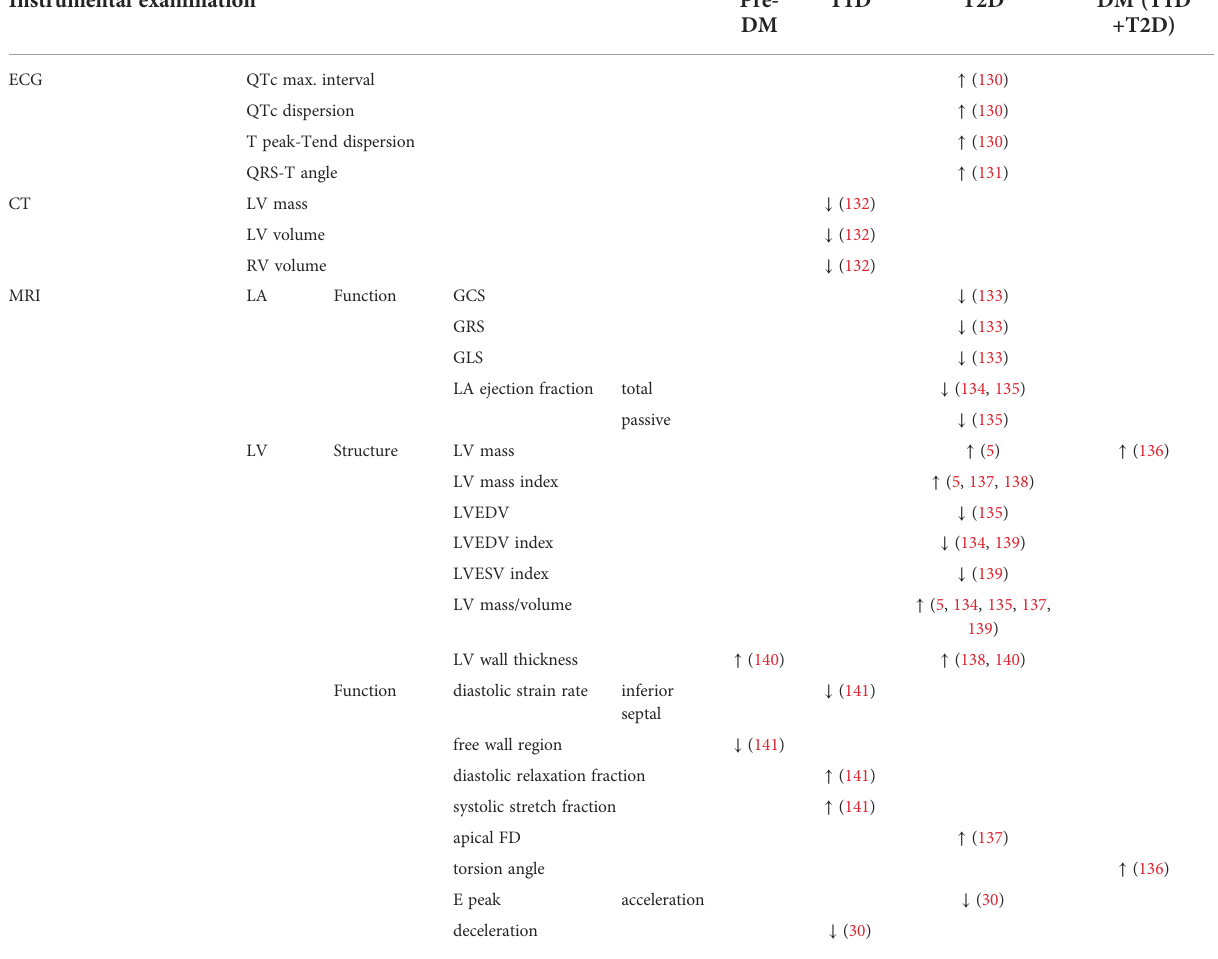
TABLE 3 Main clinical fi ndings of CT/MRI/PET and other methods for cardiac dysfunction in T1D and T2D patients. Instrumental